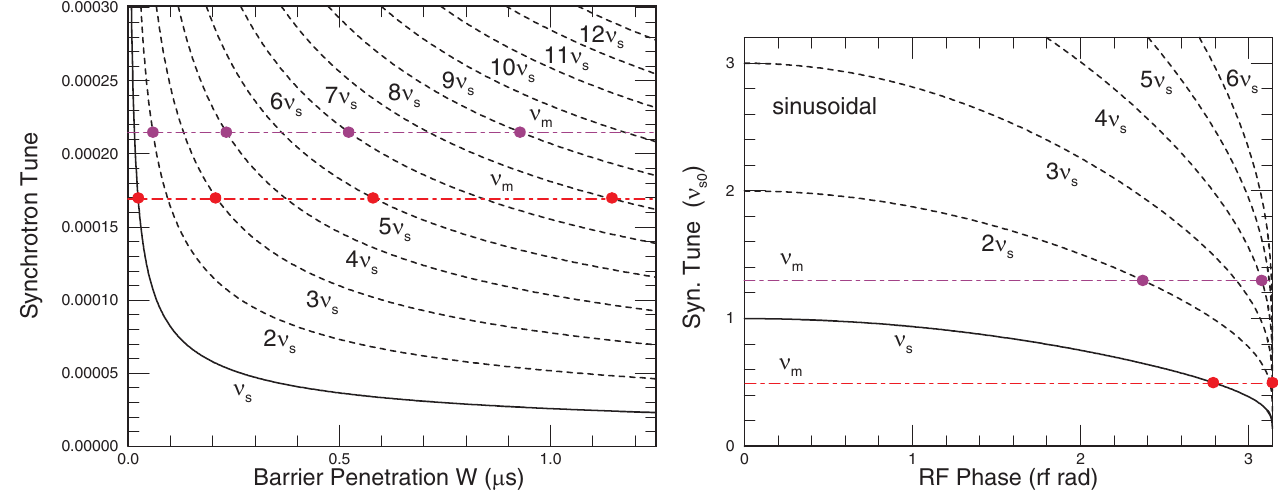
FIG. 2. (Color) Synchrotron tune and harmonics versus barrier penetration showing resonance chain (dot-dashes) starts near the center of the bucket and spreads towards the edge in a barrier bucket with zero barrier separation (left). The reverse is true for the sinusoidal rf bucket on the